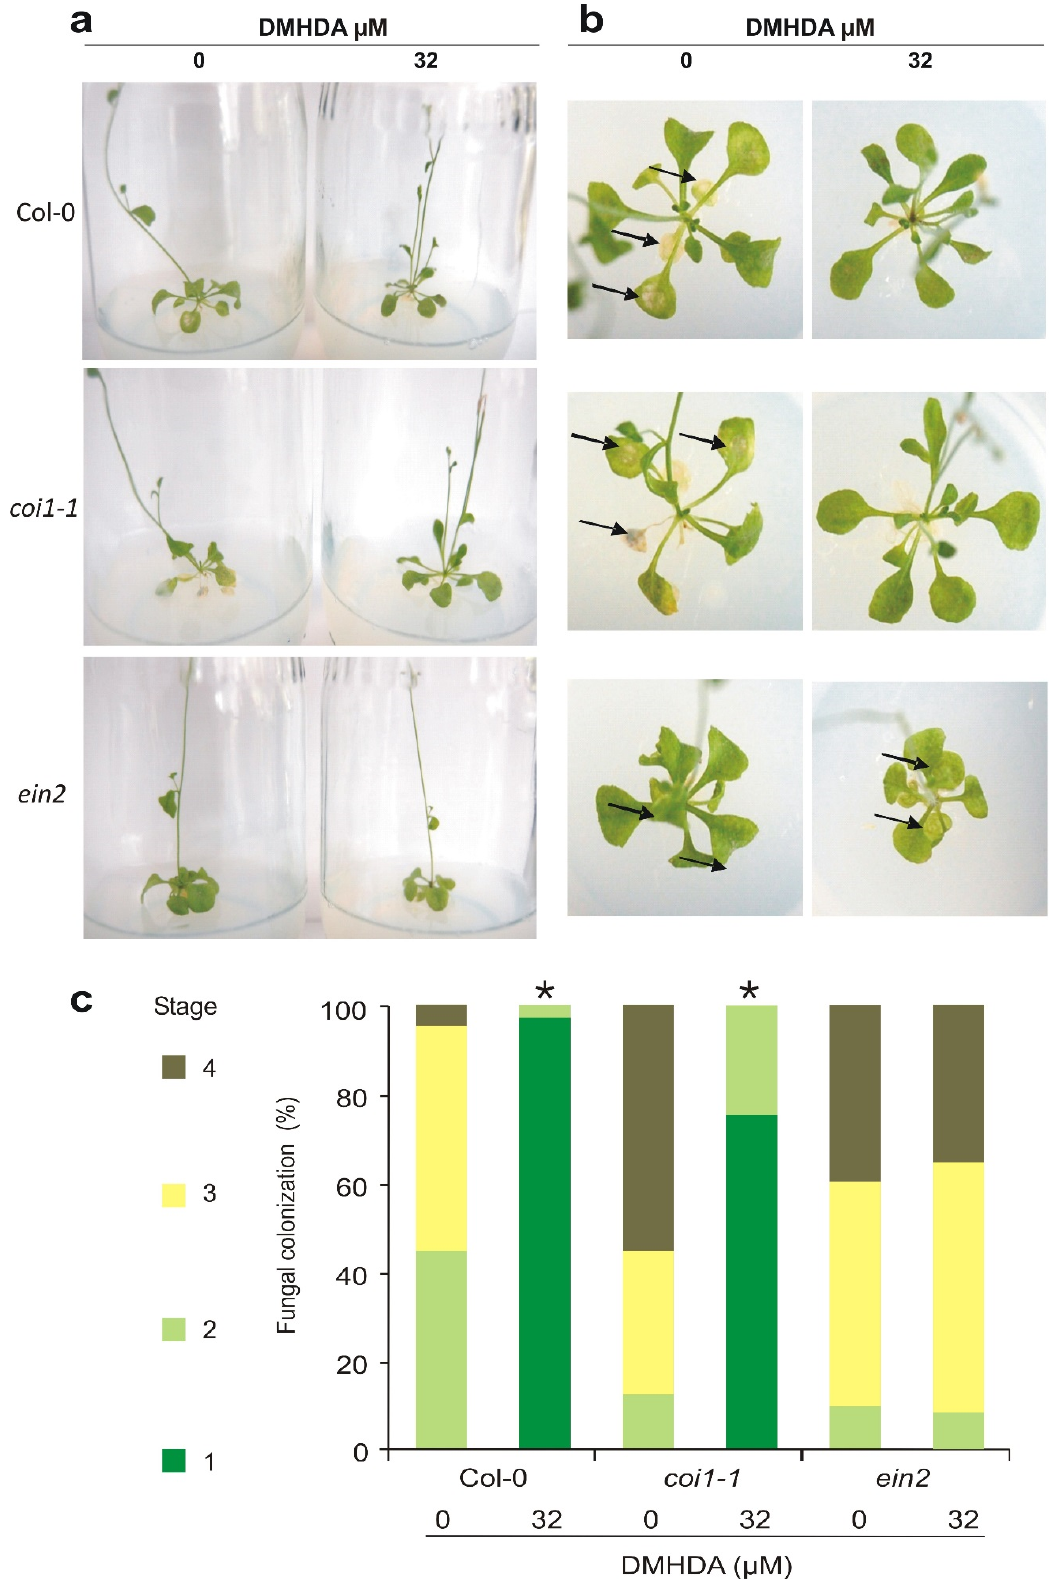
Figure 4. Role of jasmonic acid and ethylene pathways in the A. thaliana resistance against B. cinerea . Arabidopsis Col-0, coi1-1 and ein2 seedlings were cultivated in 0.2× MS medium supplied with 0 (solvent) and 32 µM of DMHDA. Plants were inoculated with 1 × 10 5 conidia/leaf of B. cinerea . Panel ( a ) shows representative photographs of a lateral view of plants three days after inoculation. Panel ( b ) view of plant rosette three days after fungal inoculation, black arrows indicate the damage caused by fungus B. cinerea . Panel ( c ) quantitation of fungal infection level in A. thaliana Col-0, coi1- 1, and ein2 . 50 leaves of each plant genotype and treatment were stained with trypan blue and clas- sified. Asterisks (*) indicate statistically significant differences in the infection stages distribution of each plant genotype (independently) compared to the control (solvent only) condition ( χ 2 test; p < 0.05). 2.5. Temporal Application of DMHDA Promotes Growth of A. thaliana